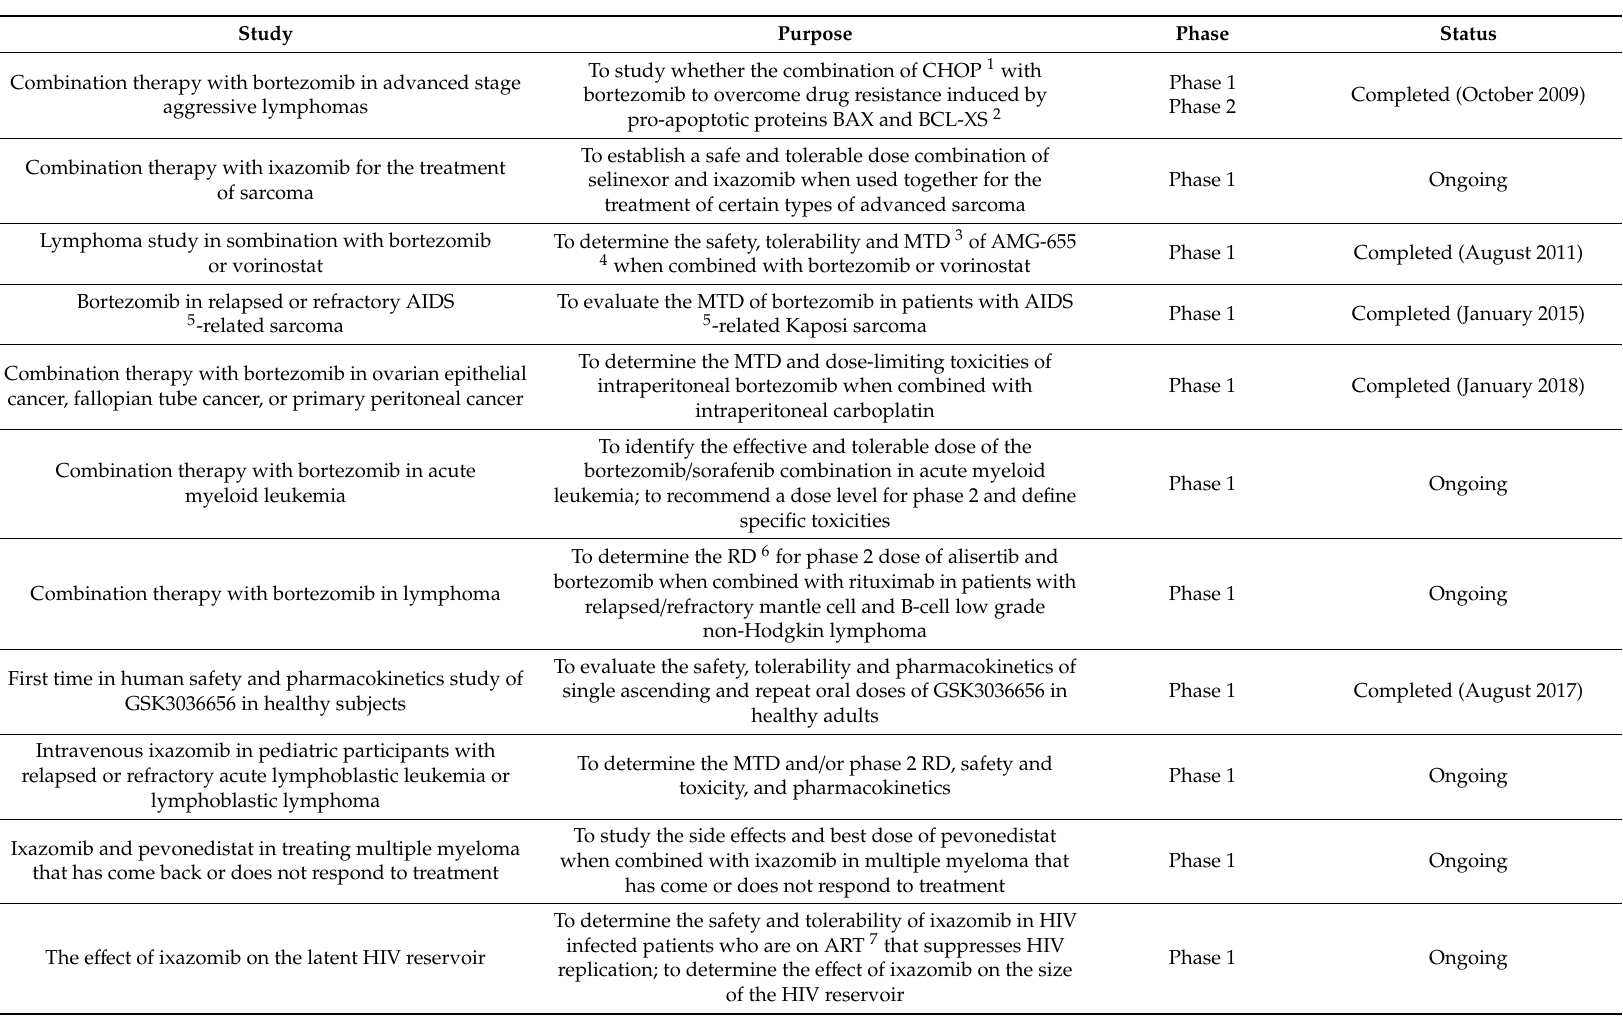
Table 1. Some of the completed and ongoing clinical trials with boronic acid compounds and other boron-containing compounds. Source: